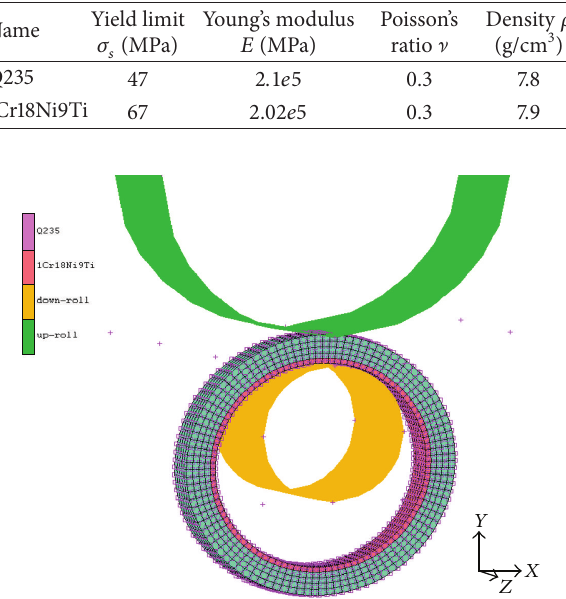
Figure 1: Bimetallic bush hot-rolled bonding